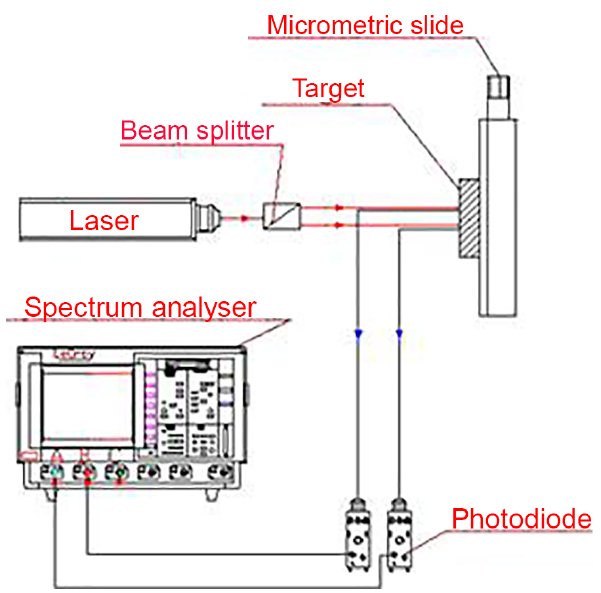
Figure 4. Sketch of the measurement chain.